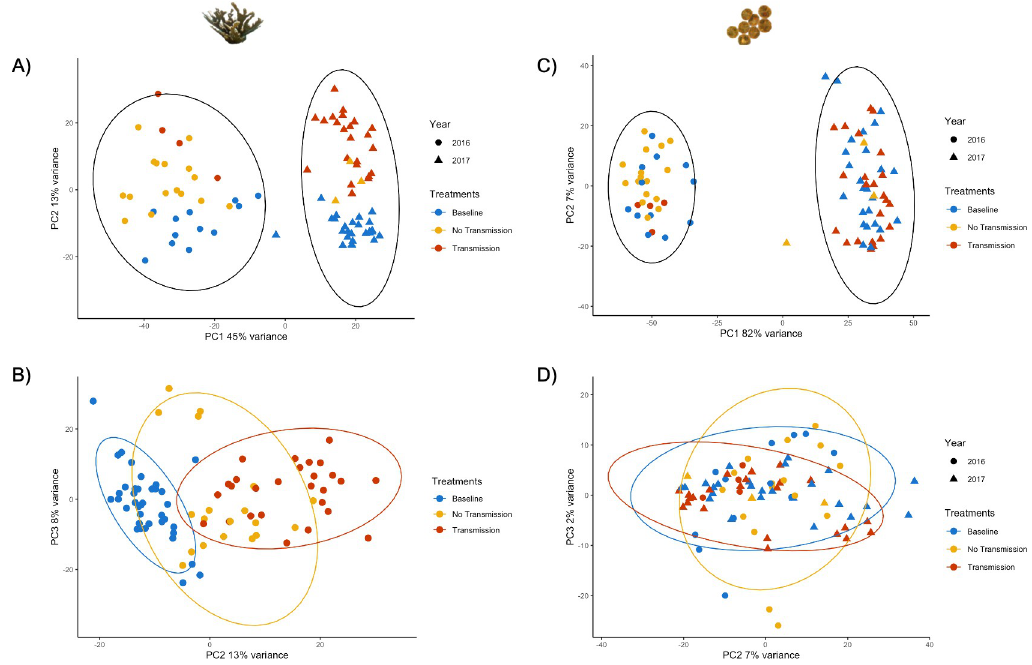
Fig 2. A . palmata and Symbiodiniaceae samples cluster by year, while disease response is only identified in the coral. A) Principal Component (PC) 1 and PC2 of A . palmata counts, using a variance stabilizing transformation (VST), identifies the difference between years as the primary driver of sample variance. B) PC2 and PC3 of A . palmata counts, using a VST, is driven by disease response. C) PC1 and PC2 of Symbiodiniaceae counts, using a VST, identifies year as the primary driver of sample variance. D) PC2 and PC3 of Symbiodiniaceae counts, using a VST, shows no effect of disease outcome. For A) and C), black ellipses represent a 95% confidence interval in 2016 and 2017. For B) and D), the colored ellipses represent 95% confidence intervals for Baseline (blue), No Transmission (yellow) and Transmission